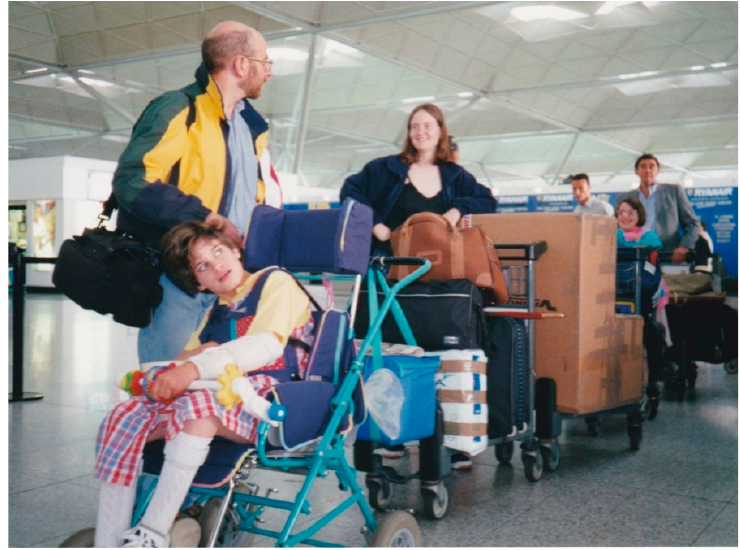
Figure 1. Checking in at the airport ahead of an international conference.